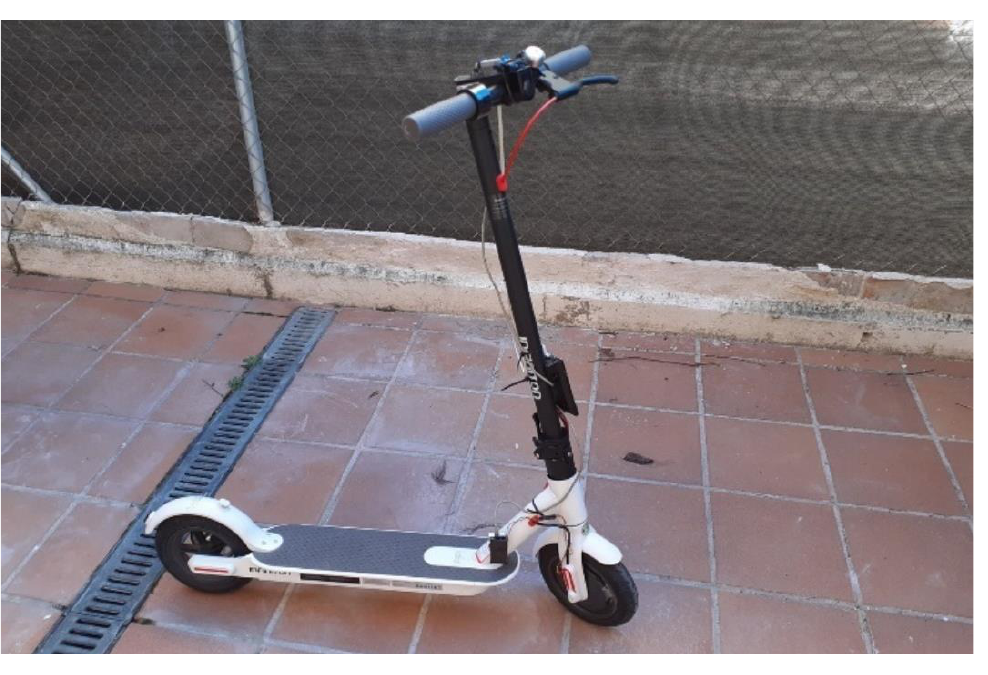
Figure 1. Sensorised